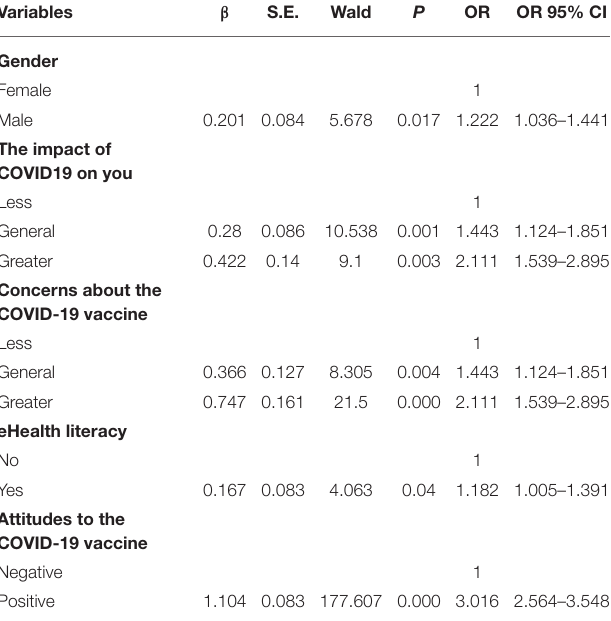
TABLE 3 | Binary logistic analysis of factors influencing willingness to receive the COVID-19 vaccination ( n =